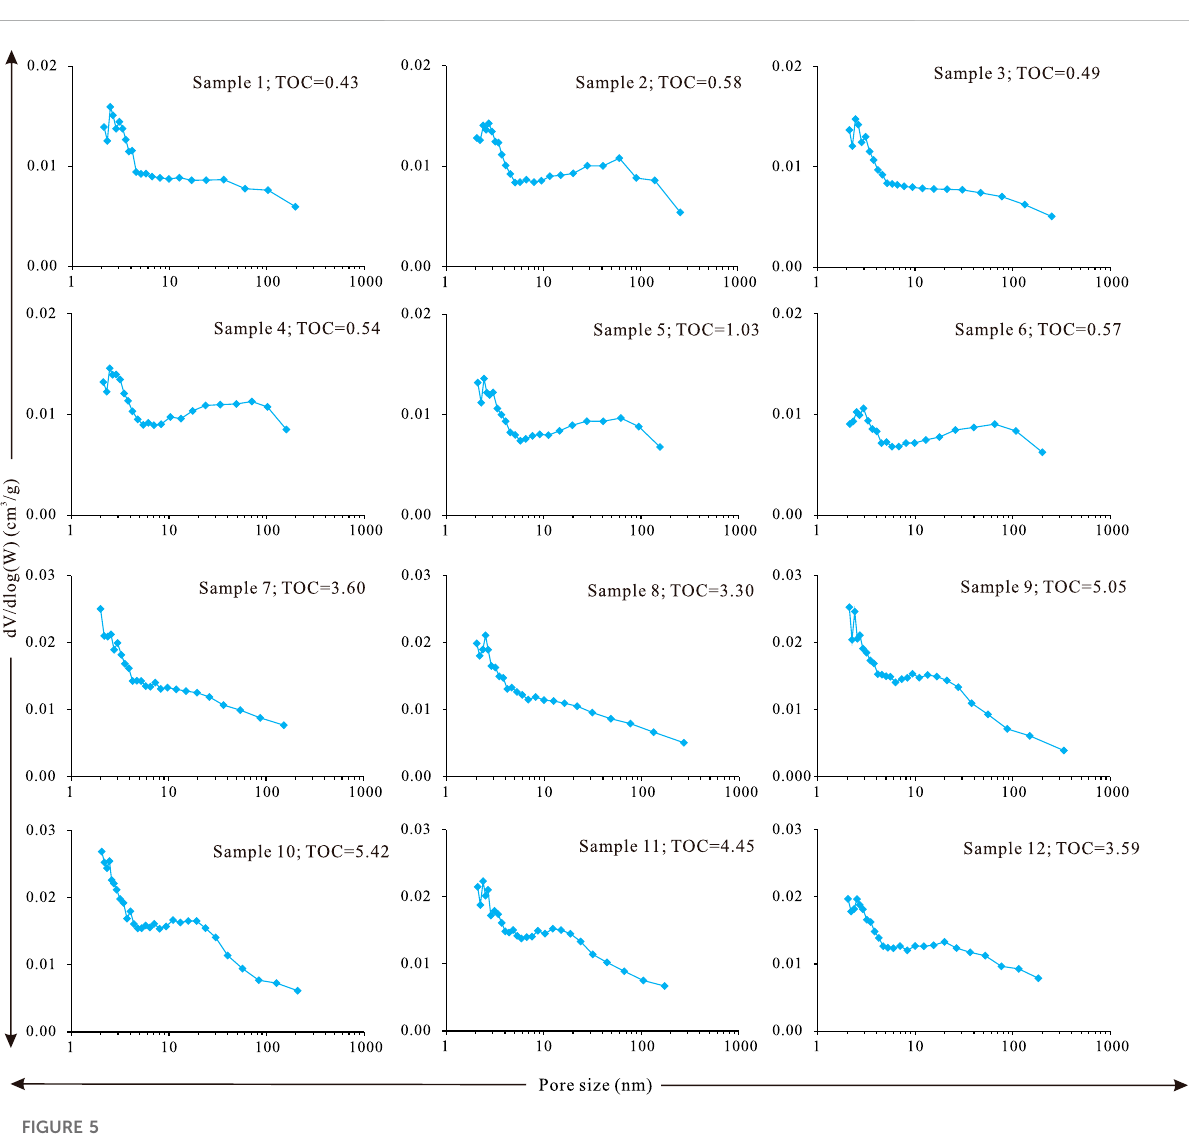
FIGURE 5 Pore size distributions obtained from LT-N 2 GA